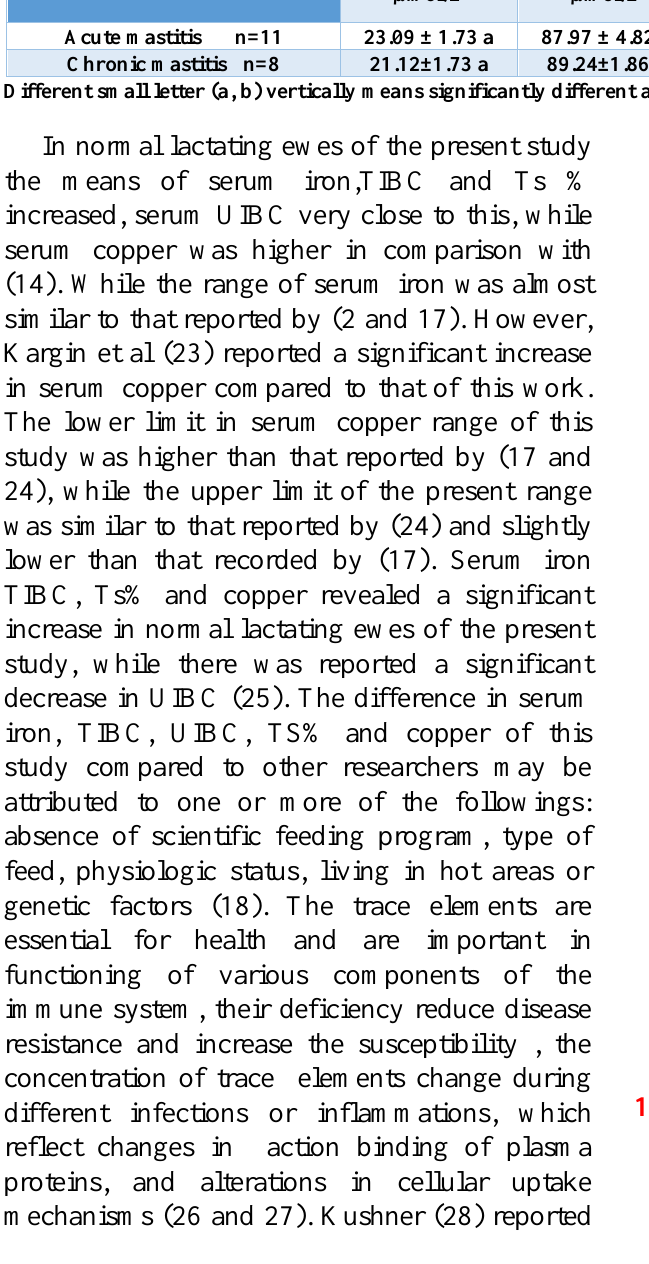
Parameters Iron TIBC UIBC TS% Copper µmol/L µmol/L µmol/L µmol/L 12.96-27.25